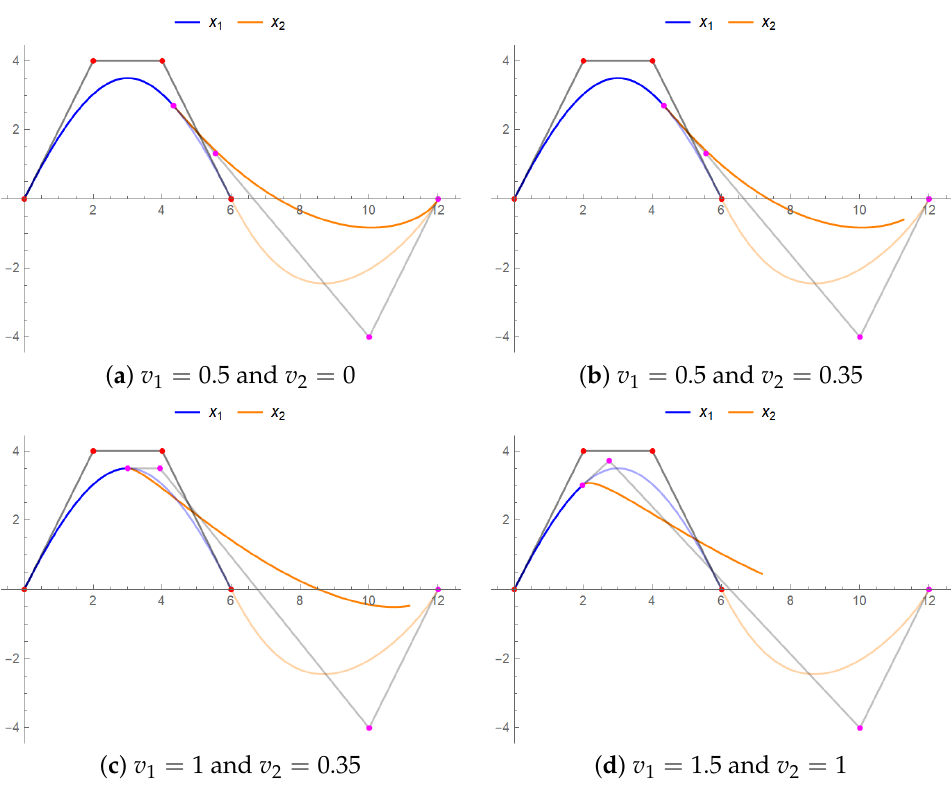
Figure 14. F 1 continuity with multiple values of v 1 and v 2